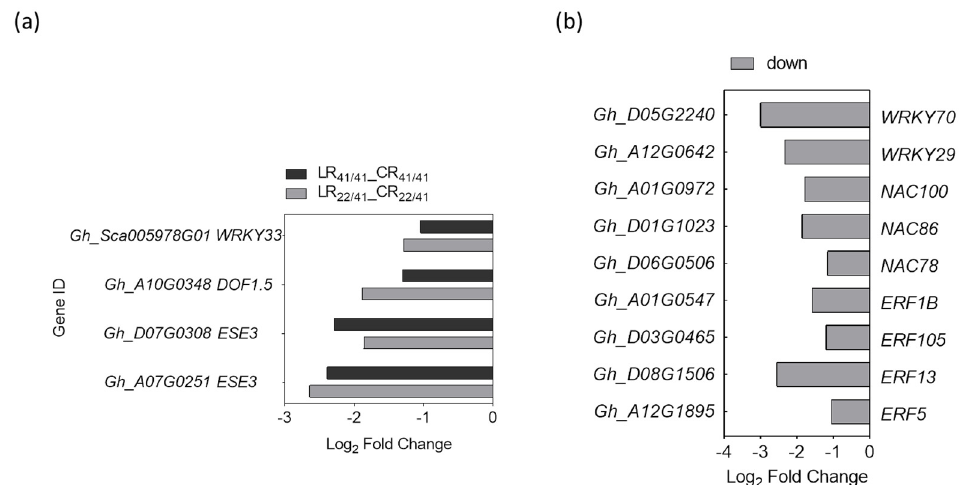
Figure 7. The predicted transcription factors (TFs) that have binding sites in the 2-kb promotor region of the K + transporter gene GhHAK5 ( Gh_D01G1760 ) in R common ( a ) and R 22/41 unique ( b ) group. R common: Common DEGs in roots of CCRI41/CCRI41 (scion/rootstock) and SCRC22/CCRI41 under potassium (K + ) deficiency. R22/41 unique: DEGs specifically identified in roots of SCRC22/CCRI41.